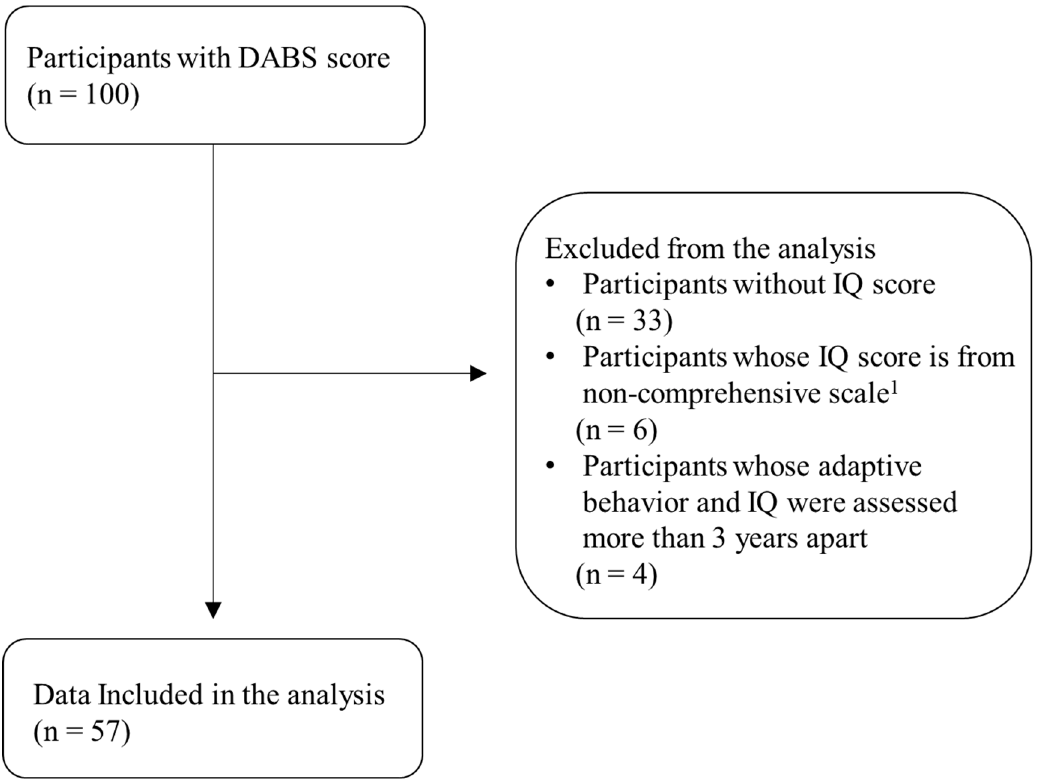
Figure 1. Flow Chart of Data Inclusion. Participants were assessed solely on a developmental scale, abbreviated/short forms or narrow-band test of intelligence (e.g., Test of Non-verbal Intelligence, Comprehensive-Test of Non-verbal Intelligence, Bayley, etc.) were excluded from the analyses.